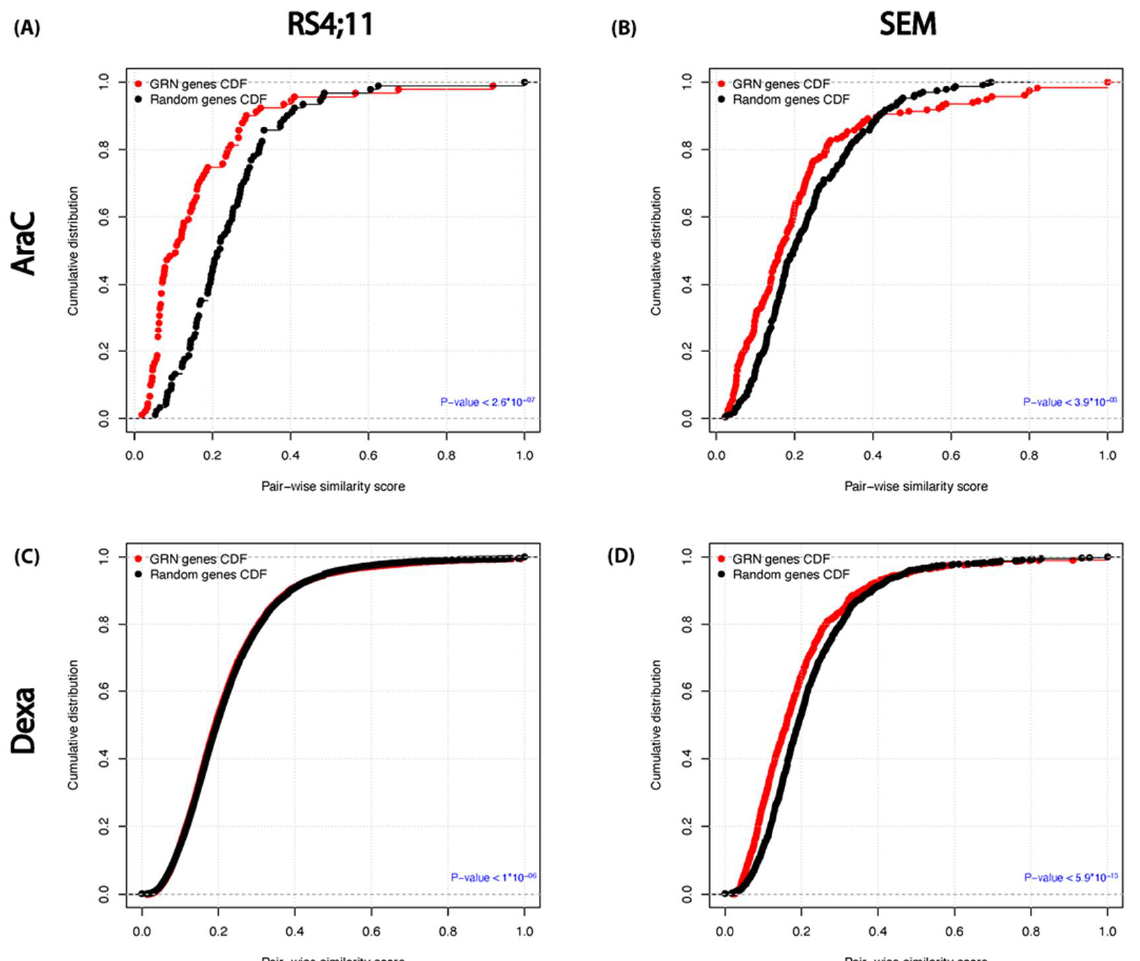
Figure 6. The functional homogeneity within each drug–GRN in the two examined cell lines. For each GRN, the cumulative distribution of GO functional semantic scores of gene pairs of the GRN (red) versus randomly selected genes (black) are depicted for ( A ) AraC in RS4;11, ( B ) AraC in SEM, ( C ) Dexa in RS4;11 and ( D ) Dexa in SEM. The corresponding p -values were calculated using the Kolgomorov–Smirnov test. The GRNs were constructed with the TFmiR web service (41) for each drug treatment based on the DEG set and the corresponding enriched miRNA set, and visualized using Cytoscape V3.3.0 [45].